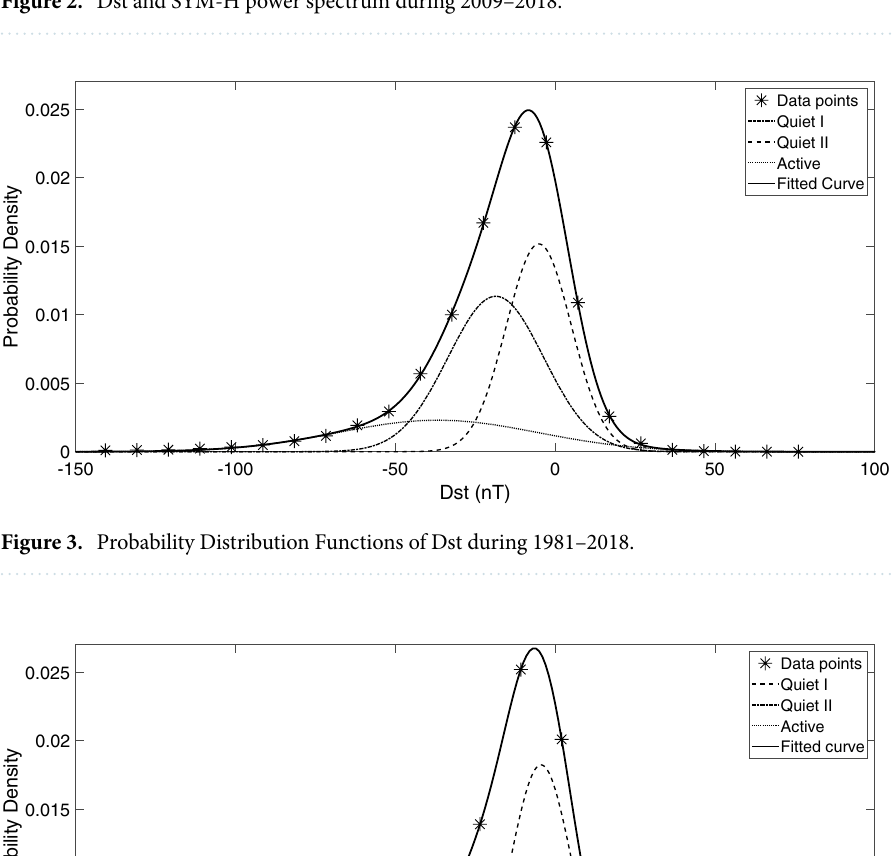
Figure 2. Dst and SYM-H power spectrum during 2009–2018.